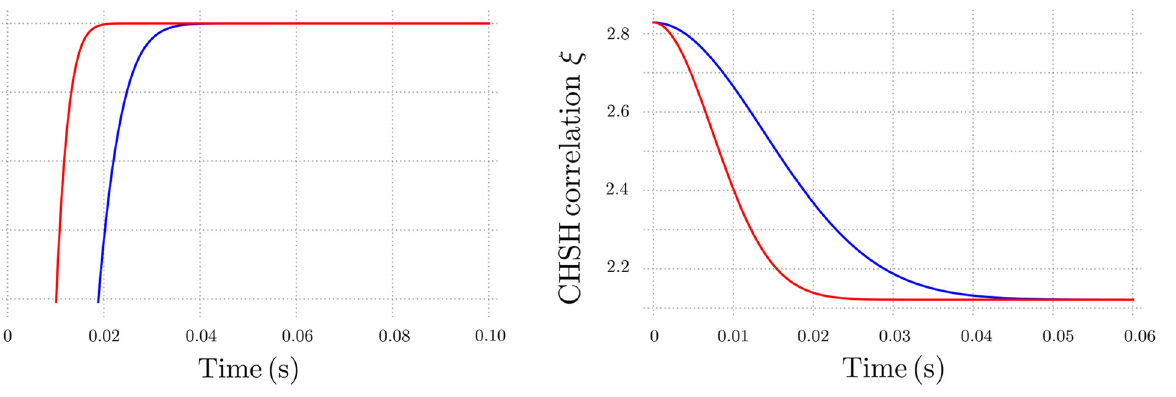
Fig. 5 Behavior of the CHSH correlation ξ ( t ) as a function of time. We analyze the cases in which quantum gravitational effects are present (red line) and absent (blue